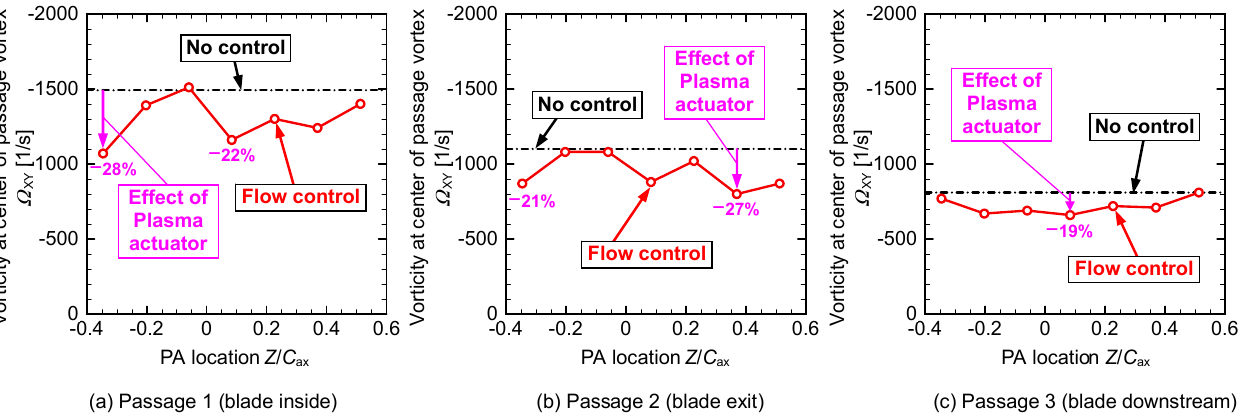
Figure 26. Effect of the plasma actuator location on peak vorticity of the passage vortex (Re out = 3.7 × 10 4